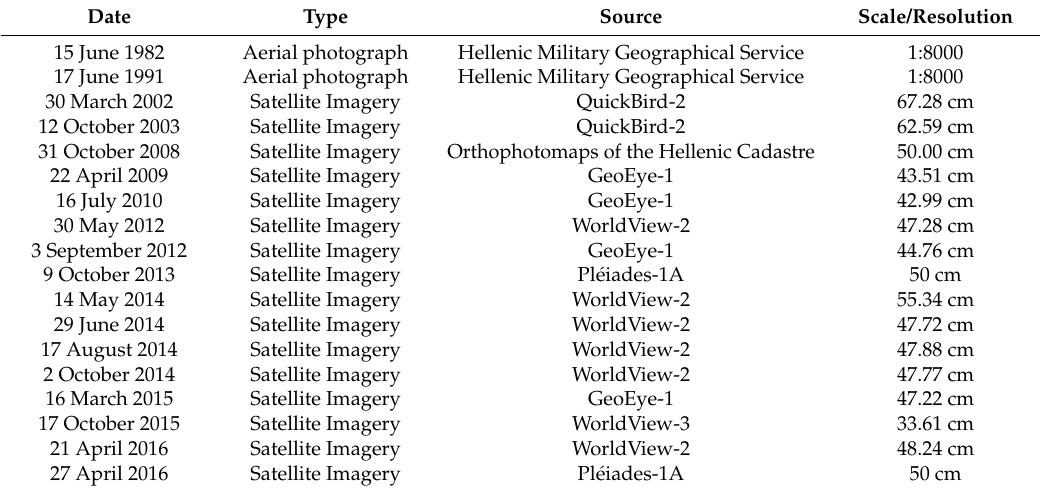
Table 1. Reference to the original data